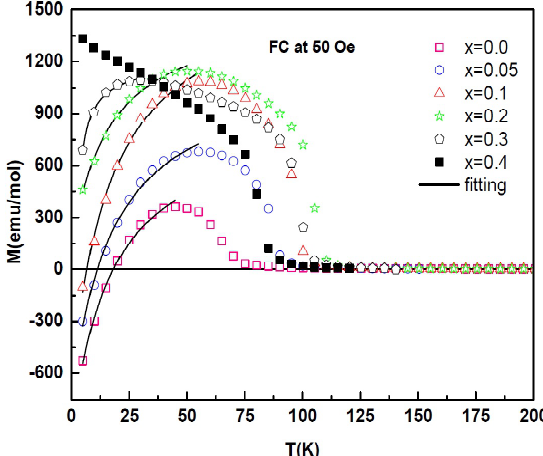
Fig. 13. Temperature dependent magnetization curves for Gd Ca Mn Cr O ( x =0.0, 0.05, 0.1, 0.2, 0.7 0.3 1- x x 3 0.3, 0.4) in FC mode. Solid line in shows Curie- Weiss type fitting using Eq. (1) of M - T data. Repro- duced from [76] with permission from